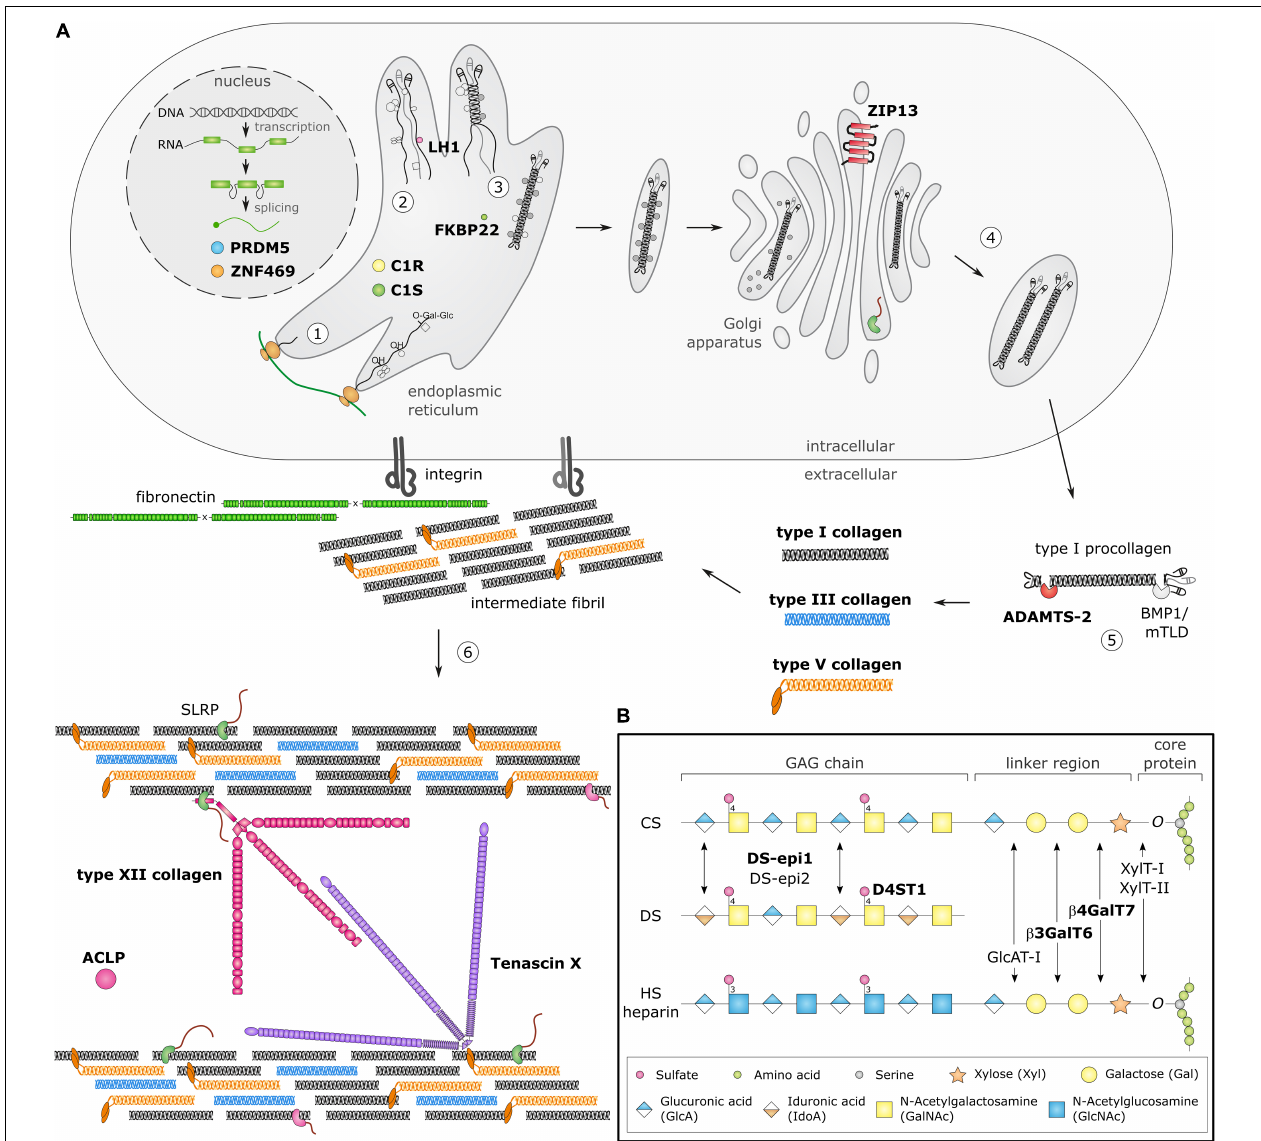
FIGURE 1 | Schematic overview of collagen and glycosaminoglycan (GAG) biosynthesis and collagen fibrillogenesis. Molecules defective in Ehlers-Danlos syndromes (EDS) are highlighted in bold. (A) Fibrillar collagen biosynthesis starts with transcription and translation of pro- α -chains (step 1). Nascent pro- α -chains are heavily post-translationally modified by several proline and lysine hydroxylases and galactosyltransferases (step 2). The association of the C-terminal propeptides of three pro- α -chains, initiates triple helix formation which propagates to the N-terminus in a zipperlike fashion and is assisted by several molecular chaperones (step 3). The trimeric procollagen molecules aggregate laterally, are transported in secretory vesicles and are eventually directed to the extracellular environment (step 4). Removal of the N- and C-propeptides, by ADAMTS-2 and BMP-1/mTLD, respectively, results in the formation of a collagen molecule (step 5) that can then assemble into highly ordered striated fibrils. The tissue-specific assembly of collagen fibrils requires the concerted action of several assisting proteins, categorized as organizers, nucleators and regulators (step 6). At the plasma membrane, fibronectin and integrins serve as organizers of fibril assembly. Some collagens, such as type V collagen, function as nucleators , which initiate immature fibril assembly at the cell surface. Type V collagen co-assembles with type I collagen into heterotypic fibrils with the entire triple helical domain of type V collagen embedded within the fibril, whereas its partially processed N-propeptide domain protrudes to the fibril surface and controls fibrillogenesis by sterically hindering the addition of collagen monomers. The intermediate fibrils are then deposited into the extracellular matrix (ECM). Stabilization of these fibrils is provided by interactions with regulators such as the small leucine-rich proteoglycan (SLRP) decorin, tenascin-X and type XII collagen, which influence the rate of assembly, size and structure of the collagen fibrils. As fibrillogenesis proceeds, fibril growth occurs through linear and lateral fusion of intermediate collagen fibrils which are subsequently stabilized by the formation of covalent intra- and inter-molecular cross-links. (B) GAG biosynthesis starts with the synthesis of a proteoglycan core protein which is subsequently modified by several Golgi-resident enzymes. Initially, a common linker region containing four monosaccharides is formed. Biosynthesis of this tetrasaccharide linker region starts with the stepwise addition of a xylose (Xyl) residue to a specific serine residue of the core protein, catalyzed by xylosyltransferase-I and II (XylT-I/-II). Subsequently, two galactose (Gal) residues are added by galactosyltransferase-I (GalT-I or β 4GalT7) and galactosyltransferase-II (GalT-II or β 3GalT6). Finally, the addition of a glucuronic acid (GlcA), catalyzed by glucuronosyltransferase-I